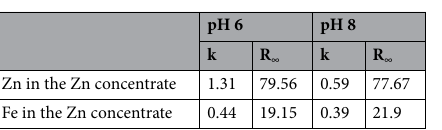
Table 4. Flotation kinetics rate parameters for zinc, and iron in the zinc flotation